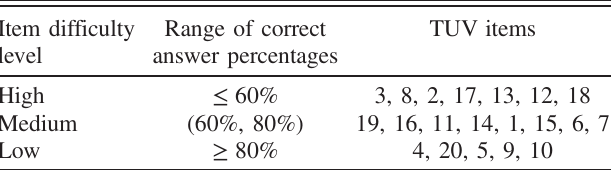
TABLE V. Division of items by difficulty level. Note that the items in each category are arranged in order of